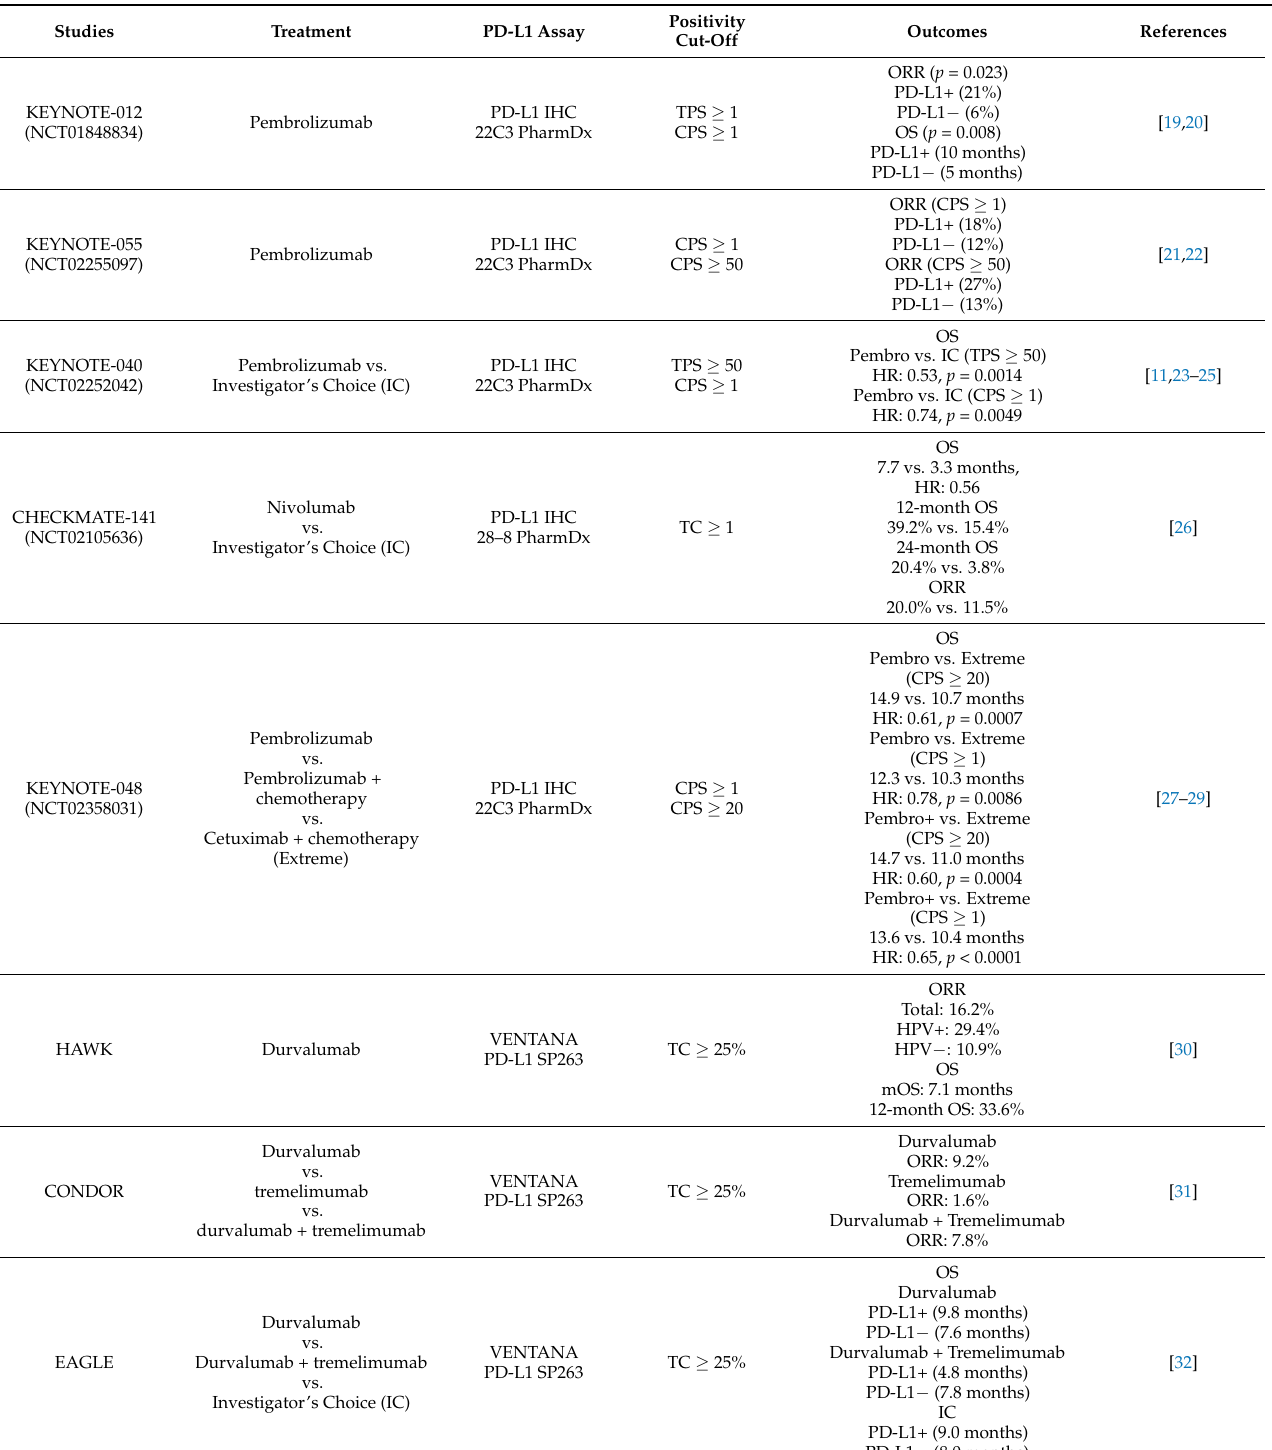
Table 1. PD-L1 biomarker data in